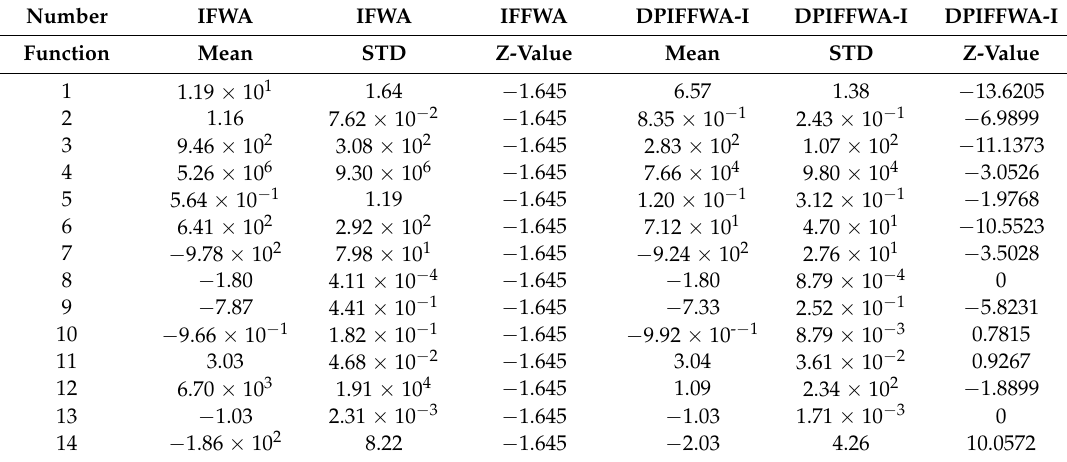
Table 15. Hypothesis test between IFWA and DPIFFWA-I with SI =